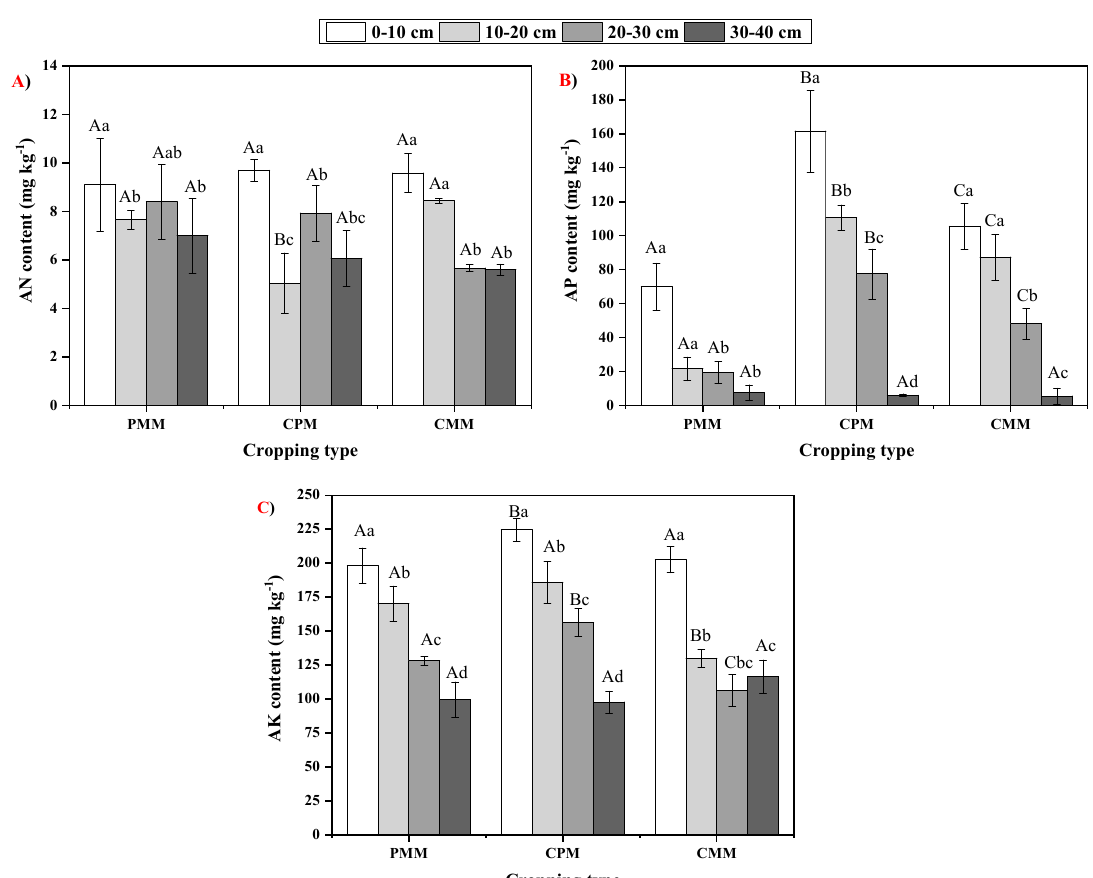
Figure 2. Variability in ( A ) soil available nitrogen (AN), ( B ) available phosphorus (AP) and ( C ) available potassium (AK) content in different soil depths in C. oleifera mono-cropping model (CMM), peanut mono-cropping model (PMM), and Camellia–peanut inter-cropping model (CPM). Two-way analysis of variance (ANOVA) test was conducted and the values in the columns are mean ± SD. Different uppercase letters indicate significant differences between cropping systems at p < 0.05, while different lowercase letters indicate significant differences among soil depths p < 0.05.